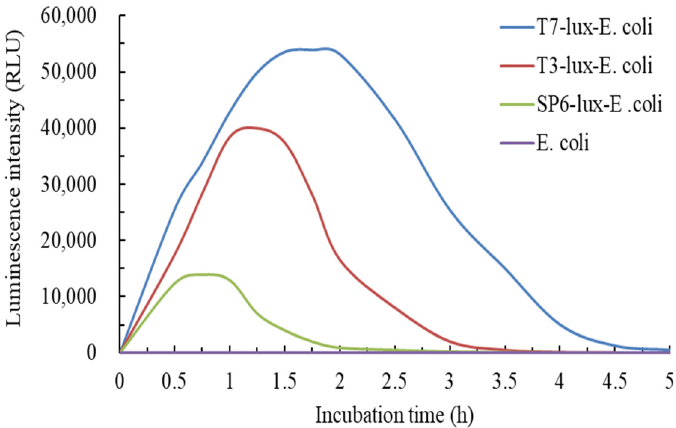
Figure 2. Time-dependent induction of luminescence from the developed three recombinant lumi- nescent E. coli biosensors and E. coli was used as a control. (initial cell concentration: 10 6 cfu/mL, culture media: modified TMM with 0.5 mg/L Cr(VI), culture temperature: 37 °C, stirring speed: 200